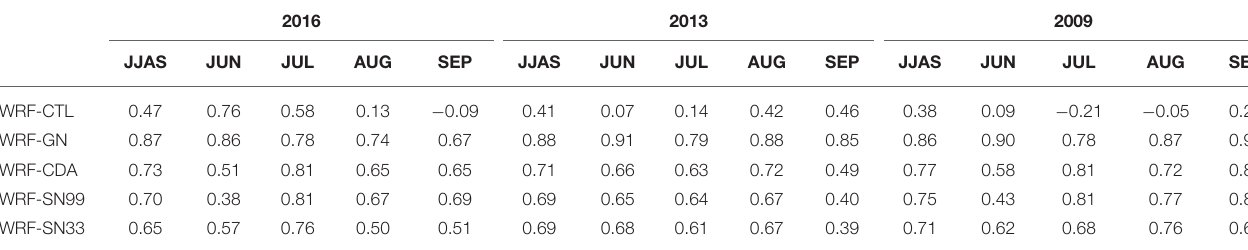
TABLE 3 | The correlation coefficients between the model and observations.